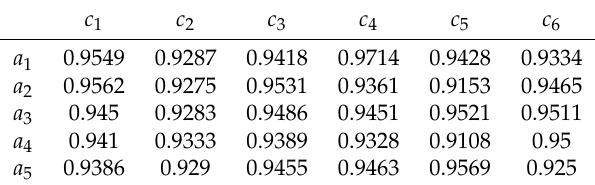
Table 10. Expectation values of hotels under di ff erent